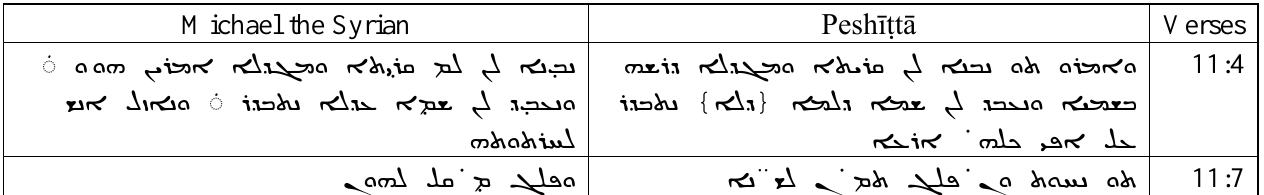
Table 2. Gn 11:4.